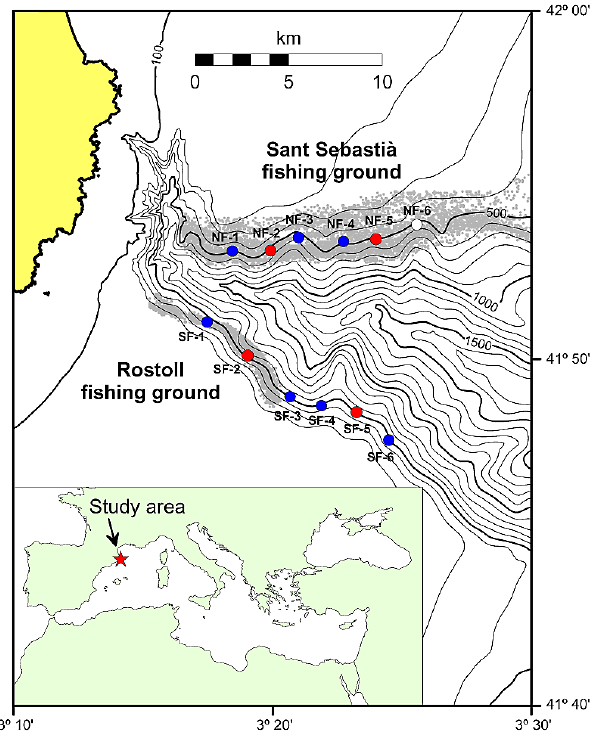
Fig. 1. Bathymetric chart of the La Fonera (Palamós) Canyon show- ing the locations of sediment sampling stations. The main fishing grounds active on the canyon flanks are defined by the clouds of grey points corresponding to vessel monitoring system (VMS) po- sitions from Palamós harbour trawlers (see Puig et al., 2012 for de- tails). Red dots correspond to coring stations visited in spring 2011 and blue dots to stations visited in autumn 2011. No sediment sam- ples could be retrieved from station NF-6 (white dot) due to the extreme stiffness of bottom sediments at that site (see the text for